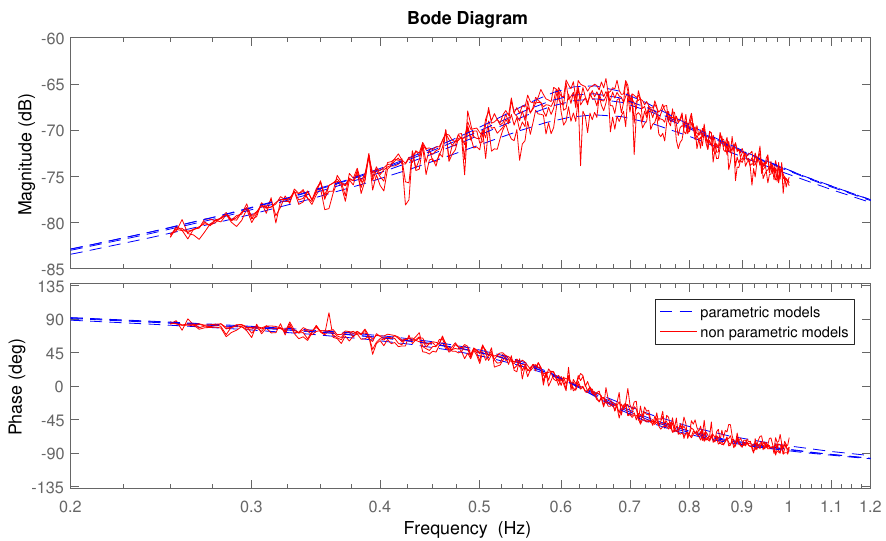
Figure 18. FRFs and Bode plots of parametric models of the intrinsic admittance Y i for different experiments, showing nonlinear behavior as the response depends on the experiment.